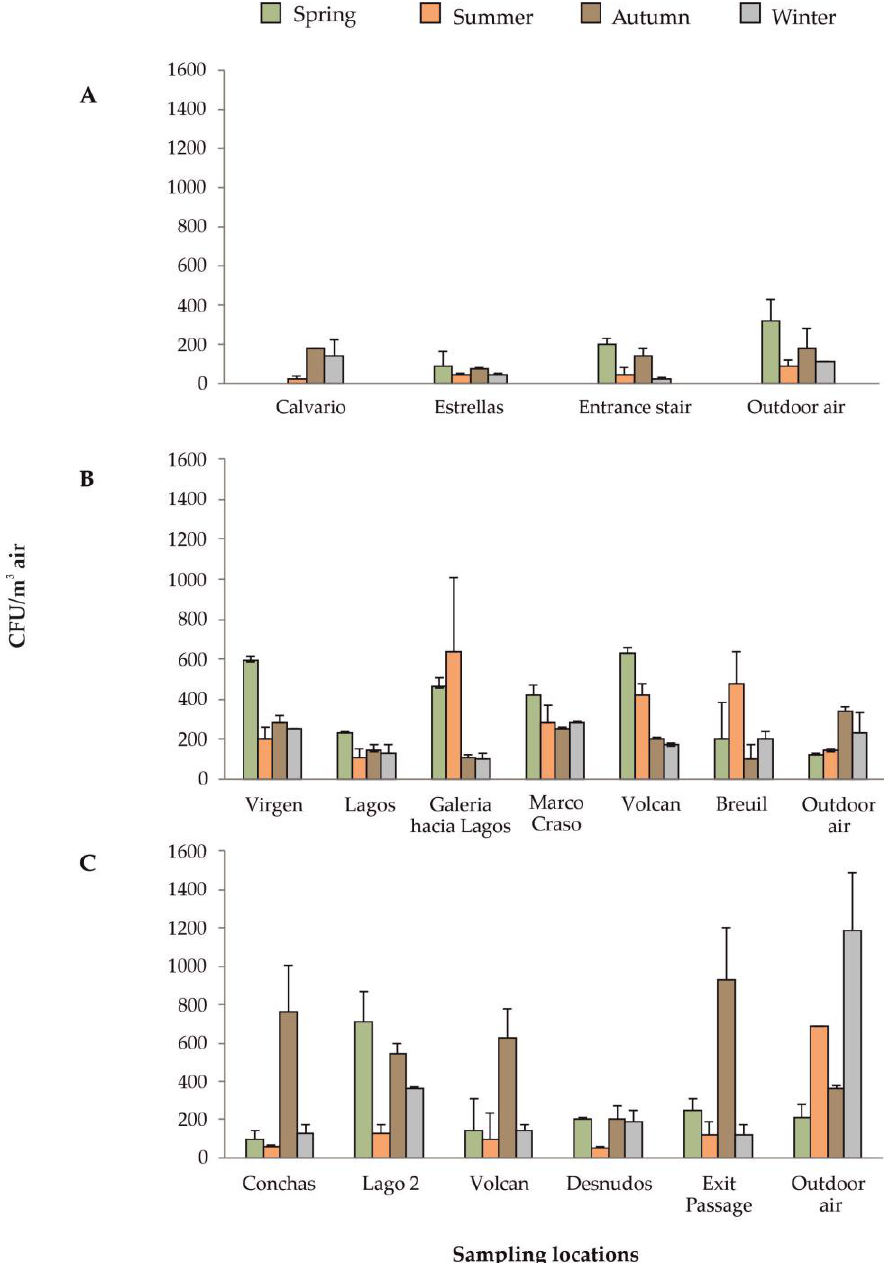
FIGURE 2: CFU m -3 of bacteria in the four seasonal samplings. (A) Cueva de Ardales ; (B) Cueva del Tesoro ; (C) Gruta de las Maravi- llas